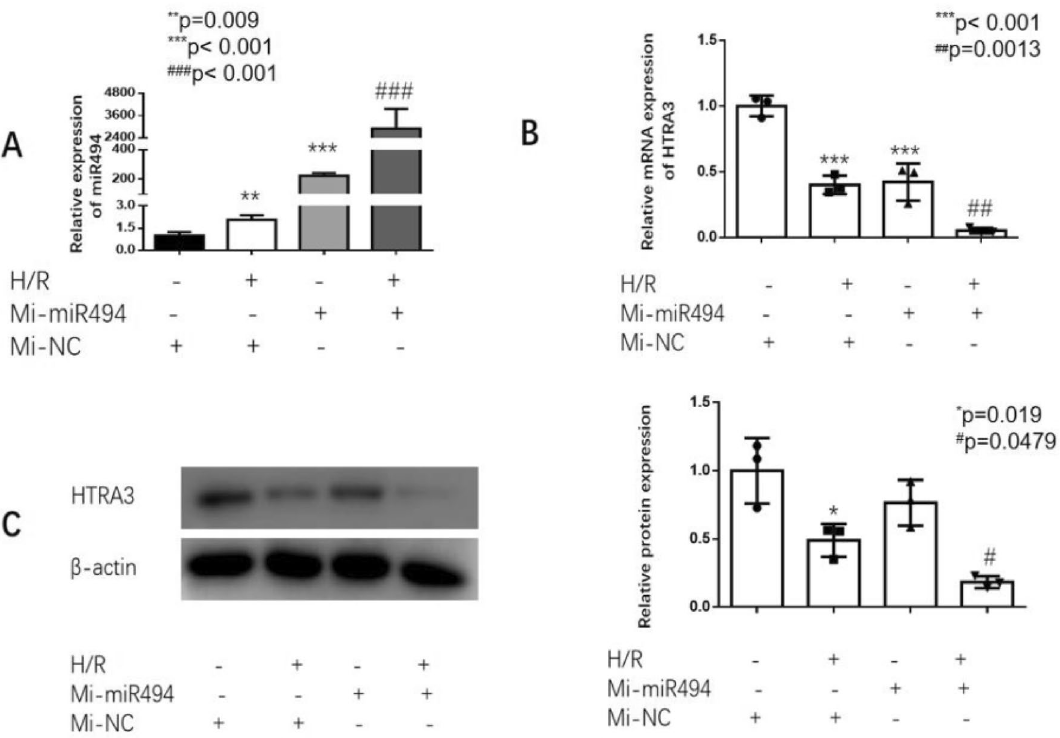
Figure 3. Hsa-miR-494-3p mimics further reduced the expression of HtrA3 by ischemia/reperfusion in HK2 cells. ( A ) Verification that hsa-miR-494-3p mimics were transfected in HK2 cells; ( B ) Real-time PCR data show hsa-miR-494-3p mimics further decreased mRNA levels of HtrA3; ( C ) Western blot data show hsa-miR-494-3p mimics has a lower expression of HtrA3 in HK2 cells, compared to the I/R. *P < 0.05, **P < 0.01, ***P < 0.001, versus control. N (the replicate for above experiments) = 3. # P < 0.05, ## P < 0.01, ### P < 0.001, versus hypoxia/ reoxygenation treatment